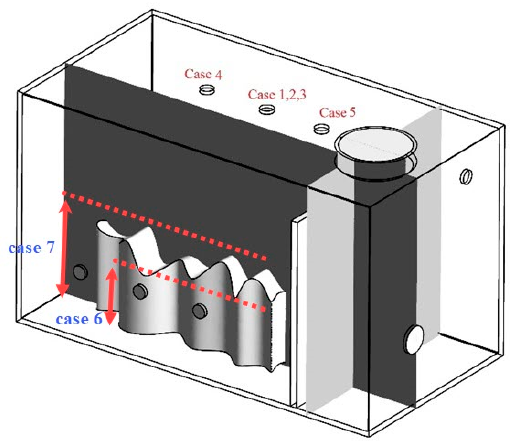
Figure 18. The place of the line at Y = 1.09 m for the numerical data extraction.